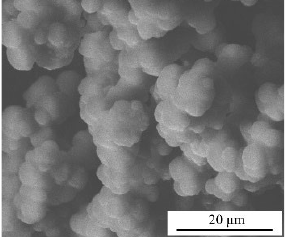
Figure 3. Morphology of the microcapsules.